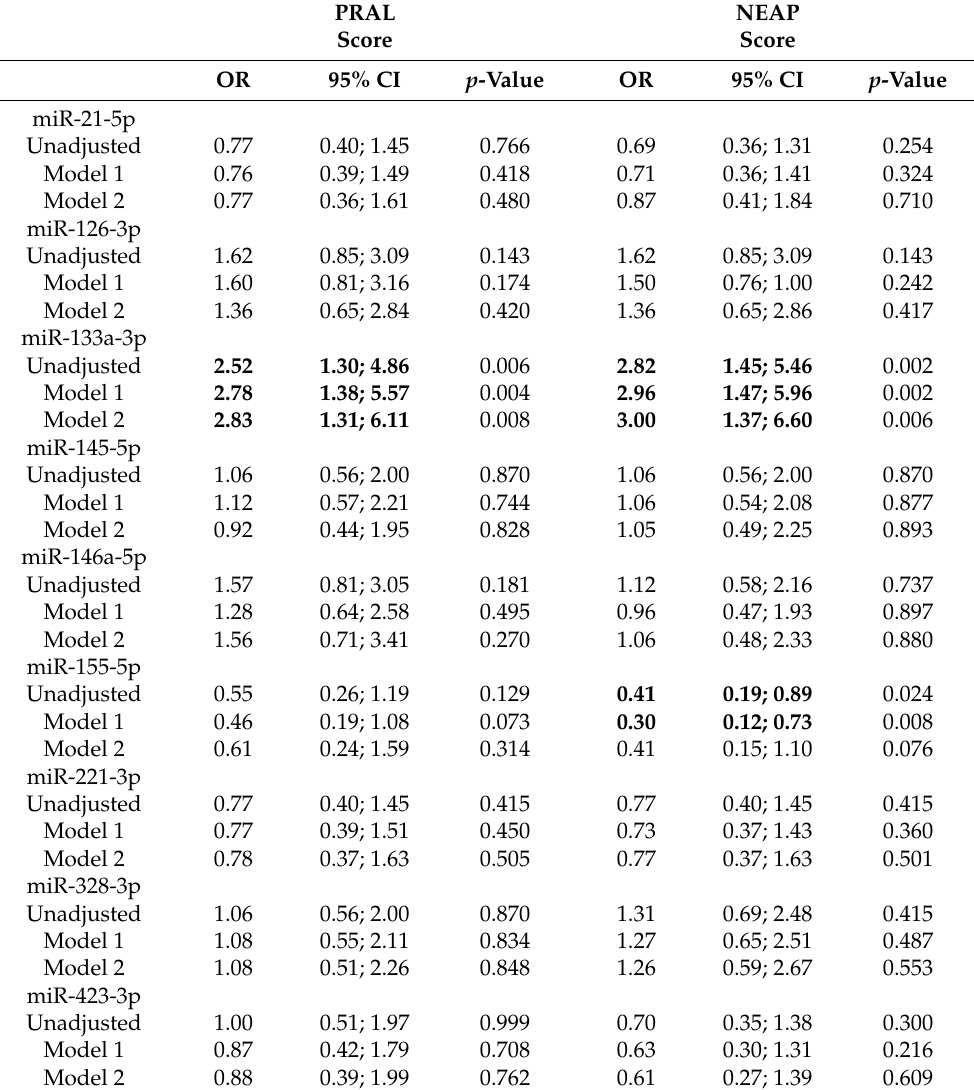
Table 2. Association between PRAL and NEAP scores with EBC miRNAs in school-aged